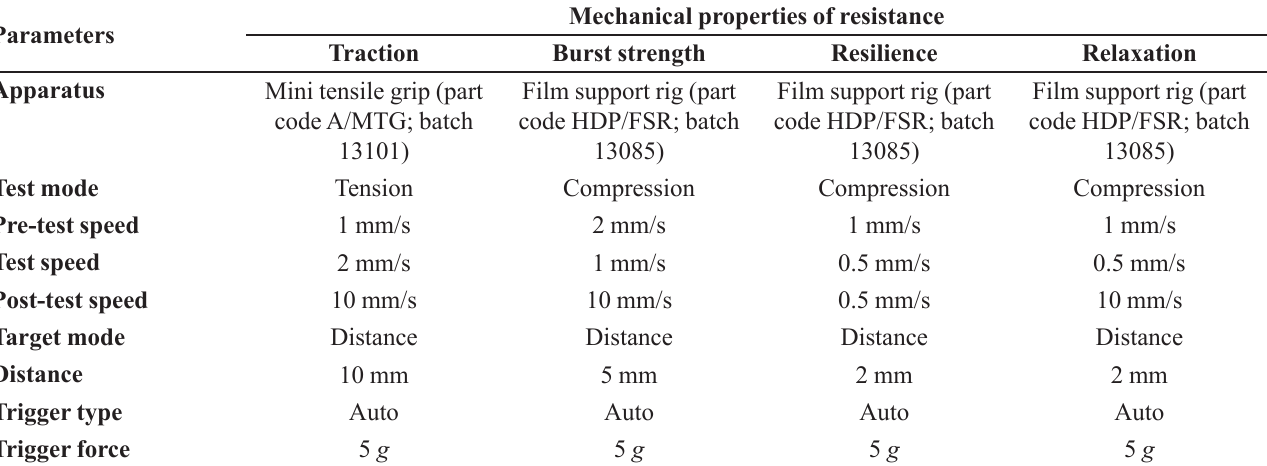
TABLE II – Parameters adopted to evaluate the mechanical properties of films